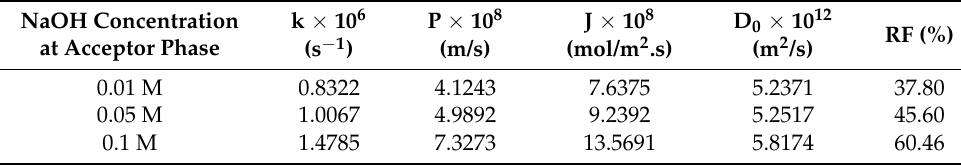
Table 5. Effect of NaOH concentration at acceptor phase on the transport of